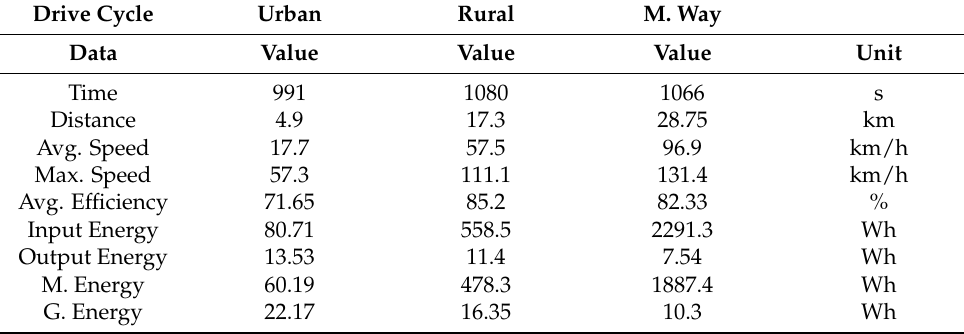
Table 5. Artemis Drive-Cycle Data for the